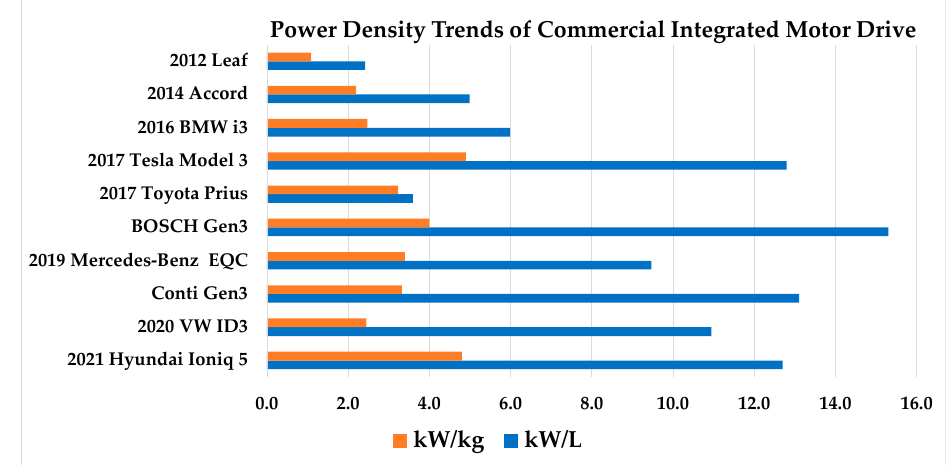
Figure 33. Estimated power density state of the art of commercially available integrated motor drive.